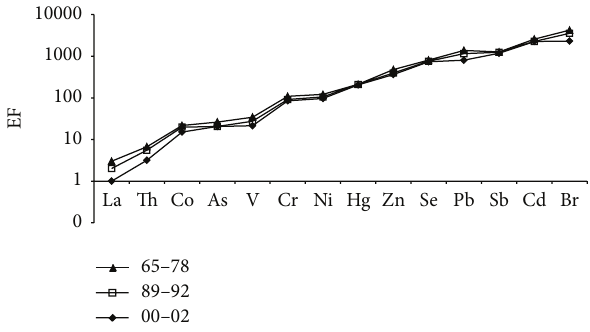
Figure 2: EF trend comparison of selected trace elements in PM10 fraction calculated using La as normalizing